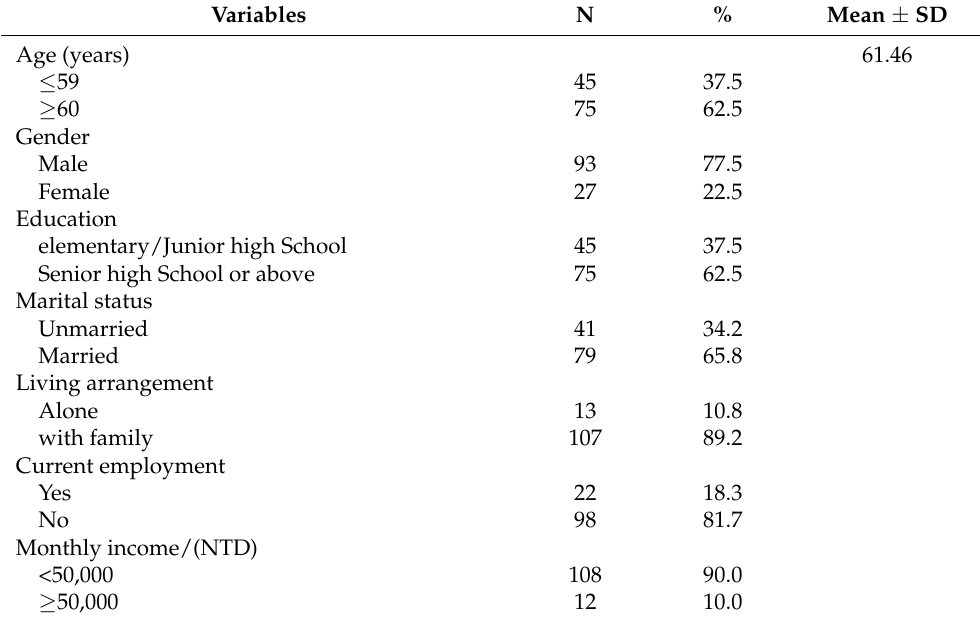
Table 1. Sociodemographic characteristics of patients on hemodialysis ( n =